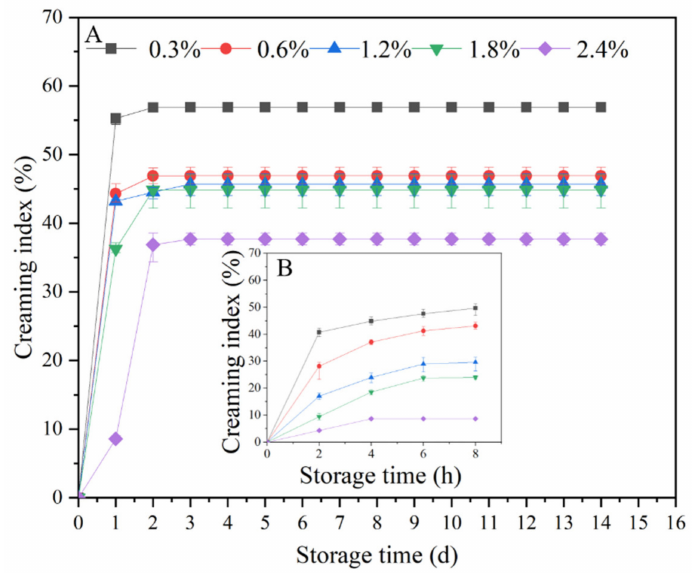
Figure 5. Changes in CI of Pickering emulsions stabilized by different concentrations of TSCPN over a storage period of 14 days ( A ) and within 8 h after preparation ( B